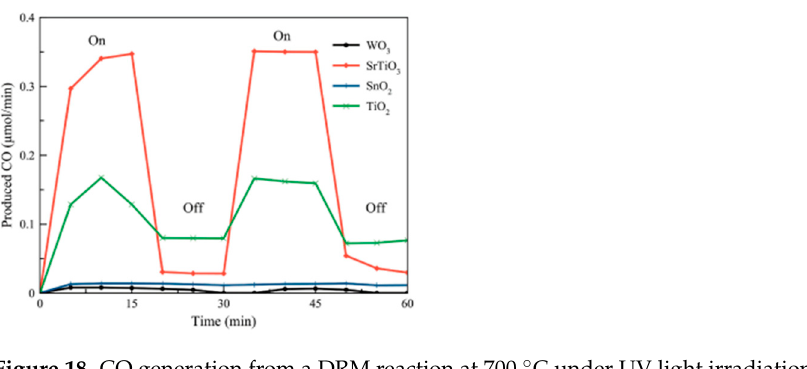
Figure 18. CO generation from a DRM reaction at 700 °C under UV light irradiation (On) and a dark condition (Off) using various metal oxide catalysts. Reprinted from [43] with permission from The Chemical Society of Japan.